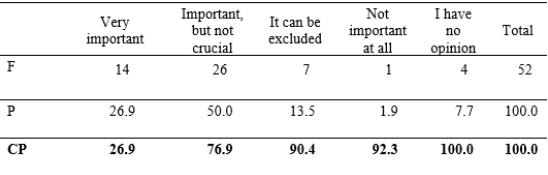
Table 16. Student's attitudes about the importance of work on rhythmic dictations